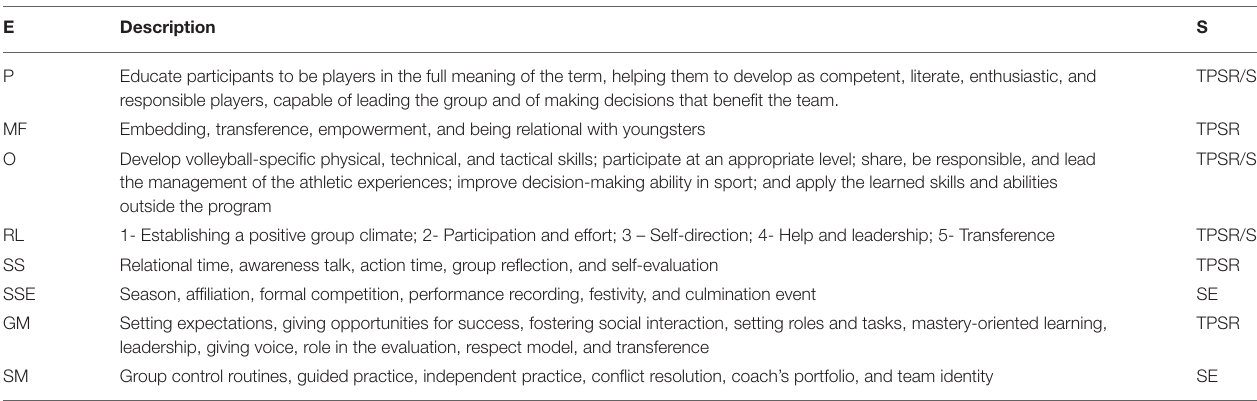
TABLE 2 | Team Sports Positive Development Program (TESPODEP)